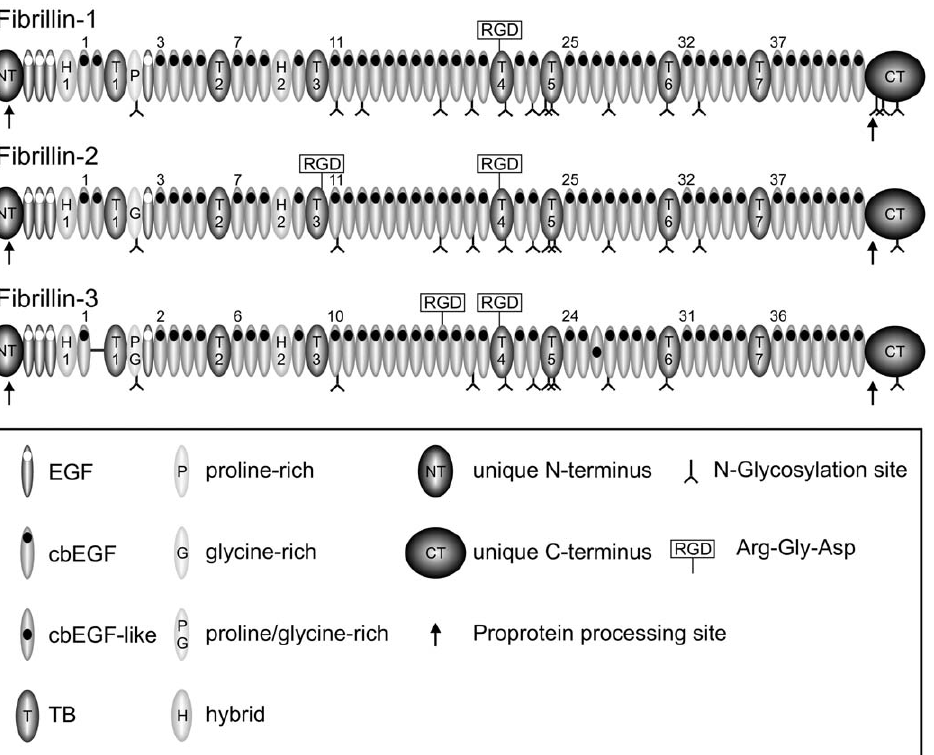
Figure 1. Overview of the domain structure of the human fibrillin family. Numbers above cbEGF domains and within TB and hybrid domains indicate the relative number of the respective domain within the human fibrillin molecule. RGD sites, proprotein processing sites in the unique N- and C-terminal domains (arrows) and predicted N-glycosylation sites (inverted Y symbols) are indicated.